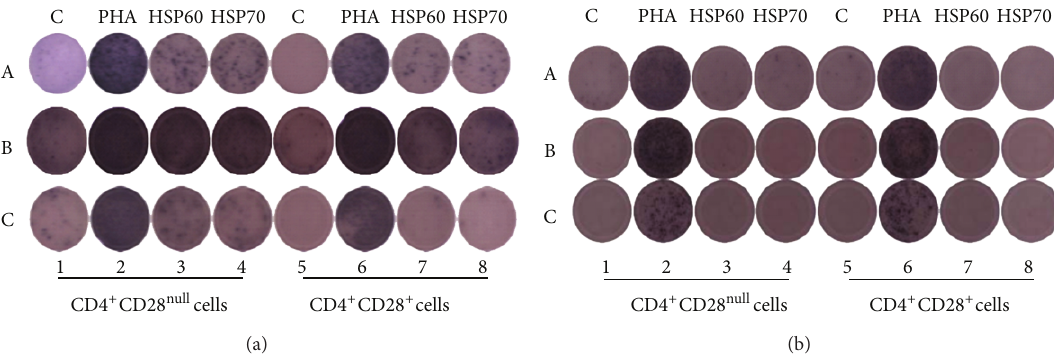
Figure 1: Representative image of ELISPOT analysis in patients with CKD (a) and healthy subjects (b): [1–4] CD4 + CD2 8 null cells and [5– 8] CD4 + CD28 + cells stimulated with and without PHA (10 𝜇 g/mL), HSP60 (5ng/mL), and HSP70 (5ng/mL), respectively. (A) Interferon- 𝛾 spots, (B) perforin spots, and (C) granzyme B spots. CD2 8 null cells responded strongly to HSP60 and HSP70 as compared to CD28 + cells as shown by the spot development for IFN- 𝛾 , perforin, and granzyme B in CKD subjects whereas there was no response as shown by lack of spot development for IFN- 𝛾 , perforin, and granzyme B in healthy controls. However, the cells responded robustly to PHA, a positive control as shown by the interferon- 𝛾 , perforin, and granzyme B spots.